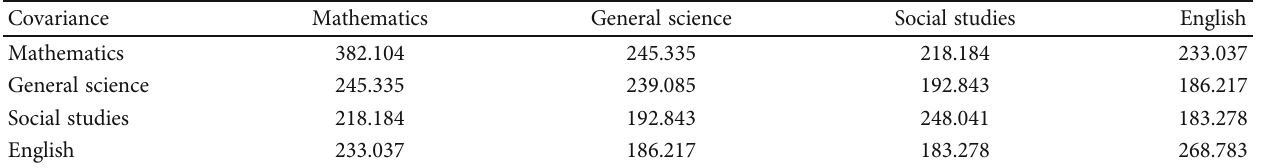
Table 12: The covariance for total nontribal boy students.